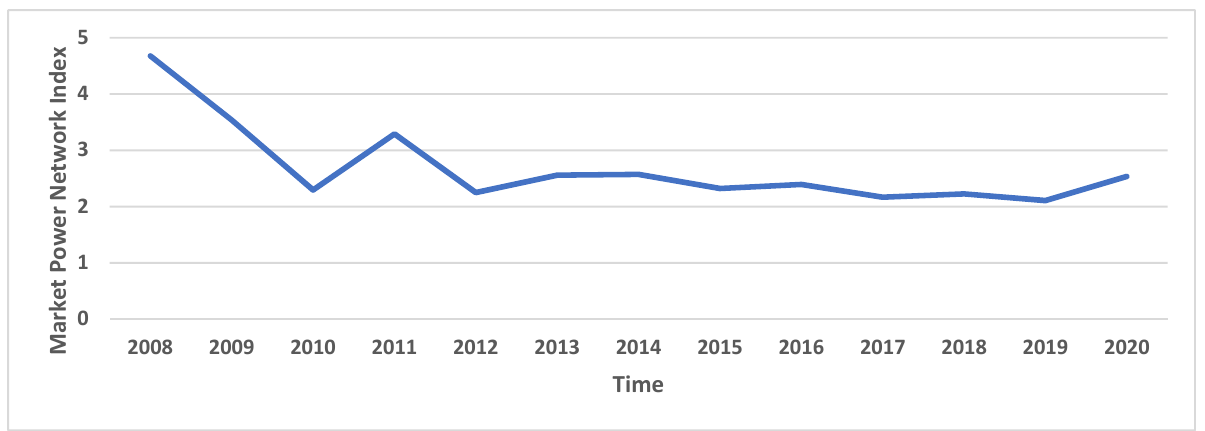
Figure 3. Time-varying Market Power Network Index Source: Authors’ own contribution. The quartile scale is used to demarcate the stages of the bank market power by providing ranges of the MPNI, as depicted in Table 4. The classification is based on a quartile scale, with a bank having a MPNI below the first quartile being considered as low, an MPNI between first quartile and median is classified as semi-moderate, an MPNI between median and third quartile is identified as moderate, and an MPNI above the third quartile is considered to have high market power. Further, during GFC, 15 banks (almost 50% of our sample) fell under the category of bearing high market power. However, dur- ing the COVID-19 period, eight banks fell into the high and moderate categories.